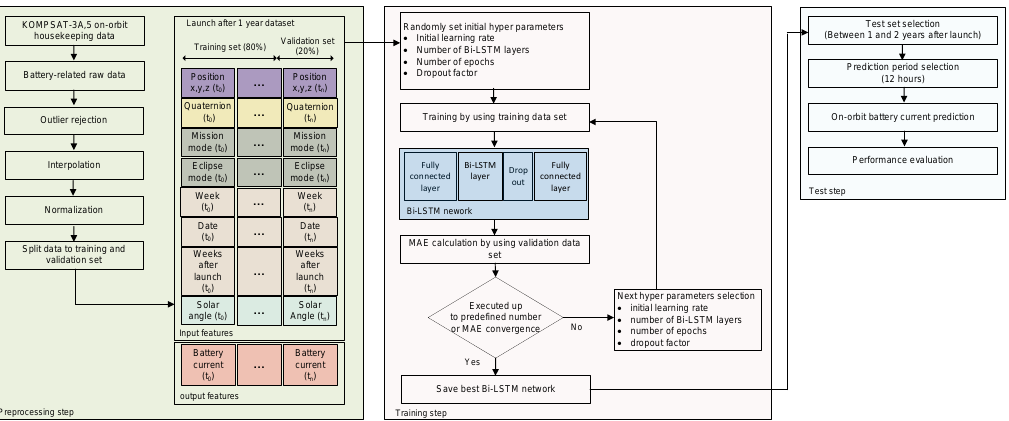
Figure 4. Proposed framework of battery current prediction.